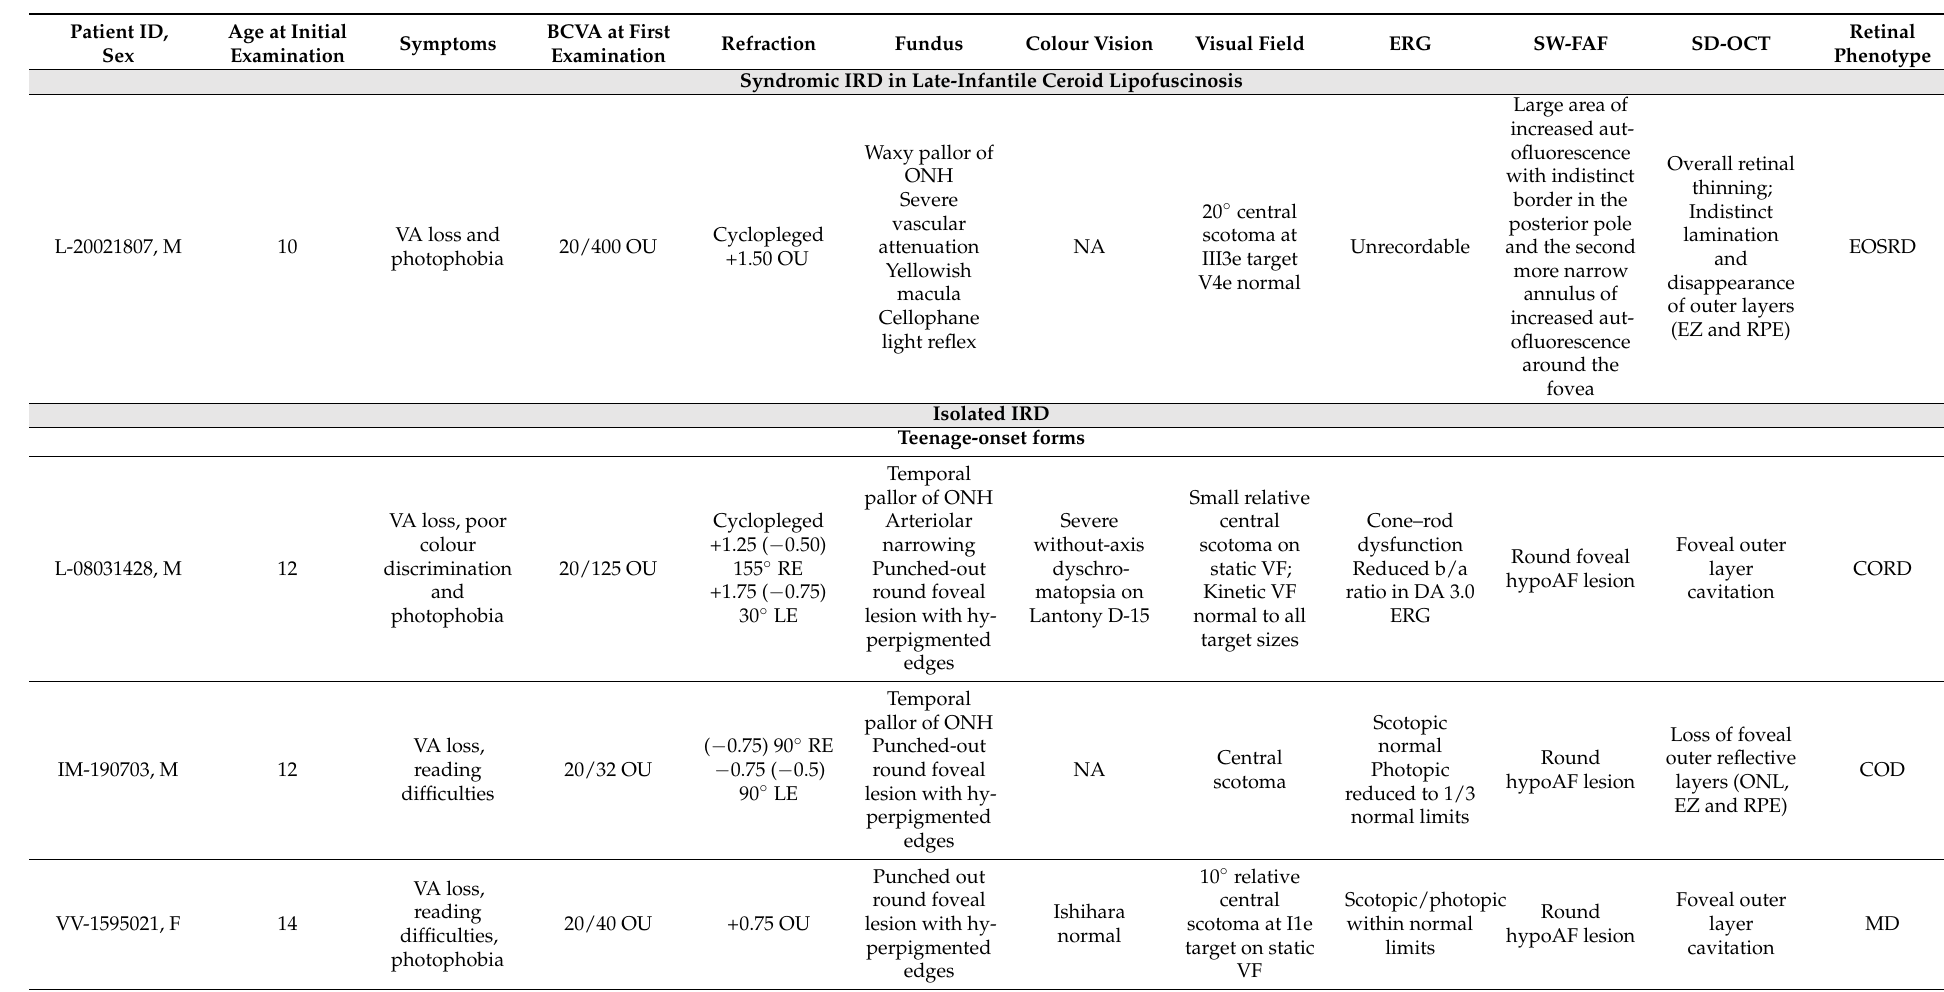
Table 1. Clinical